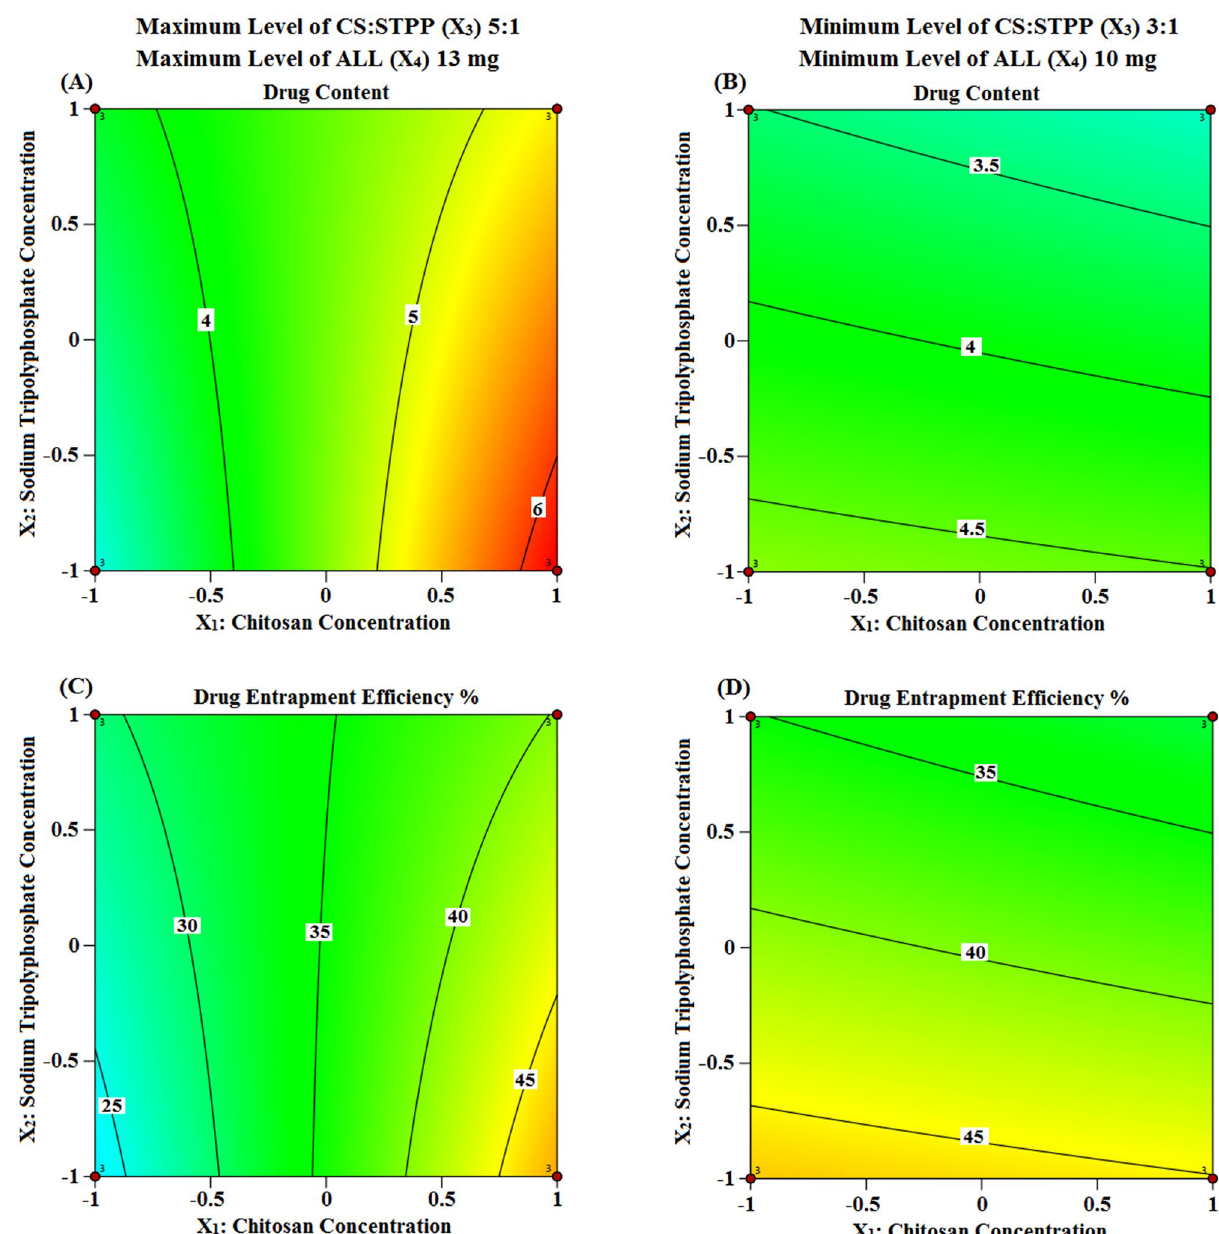
Figure 3. Contour plots representing the effect of the interaction between the concentrations of both CS (X 1 ) and STPP (X 2 ) on Q and DEE % ( A and B ) and ( C and D ) at the maximum and minimum levels of both CS:STPP volume ratio (X 3 ) and ALL amount (X 4 ), respectively, using Design-Expert version 12 (/https ://www. state ase.com/softw are/desig n-exper